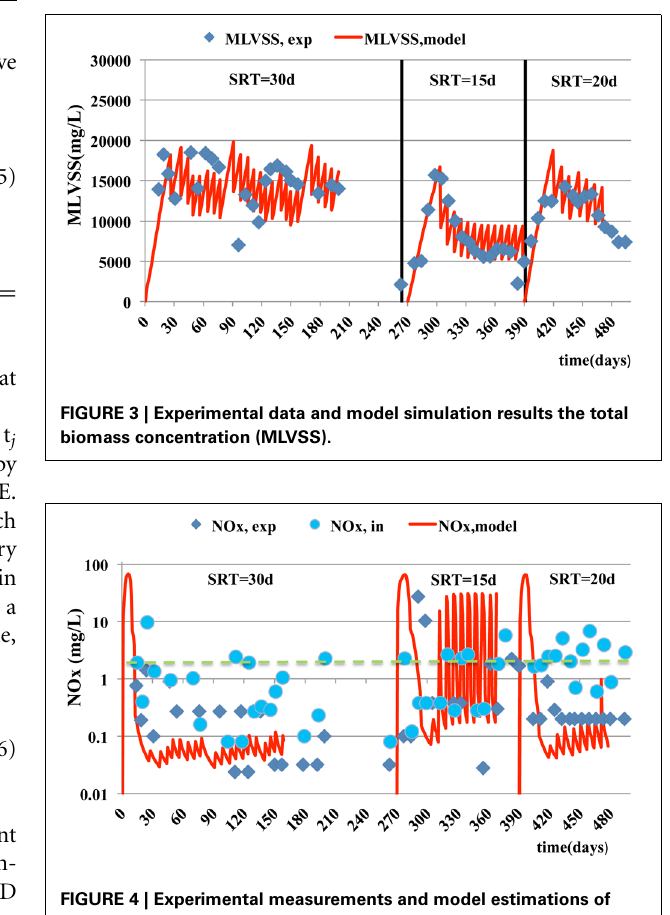
FIGURE 4 | Experimental measurements and model estimations of NO3-N and NO2-N (SNOX) in the effluent ( ___ ). Influent concentration is also shown (- - -